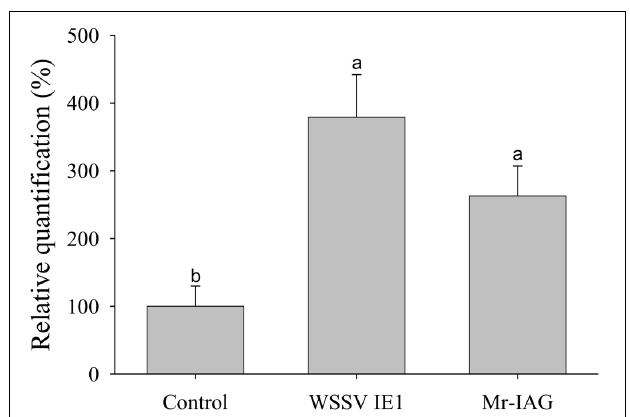
FIGURE 10 | qPCR analysis of MrLEDGF expression level in Mr-IAG transduced M. rosenbergii primary cell cultures. The relative quantification of the levels of MrLEDGF expression in uninfected cells, WSSV IE1-infected cells, and Mr-IAG-infected cells were determined by qPCR and normalized to control group and presented as relative quantification (%). For all samples n = 7. Different letters represent groups that are significantly different ( p < 0.05); error bars represent standard